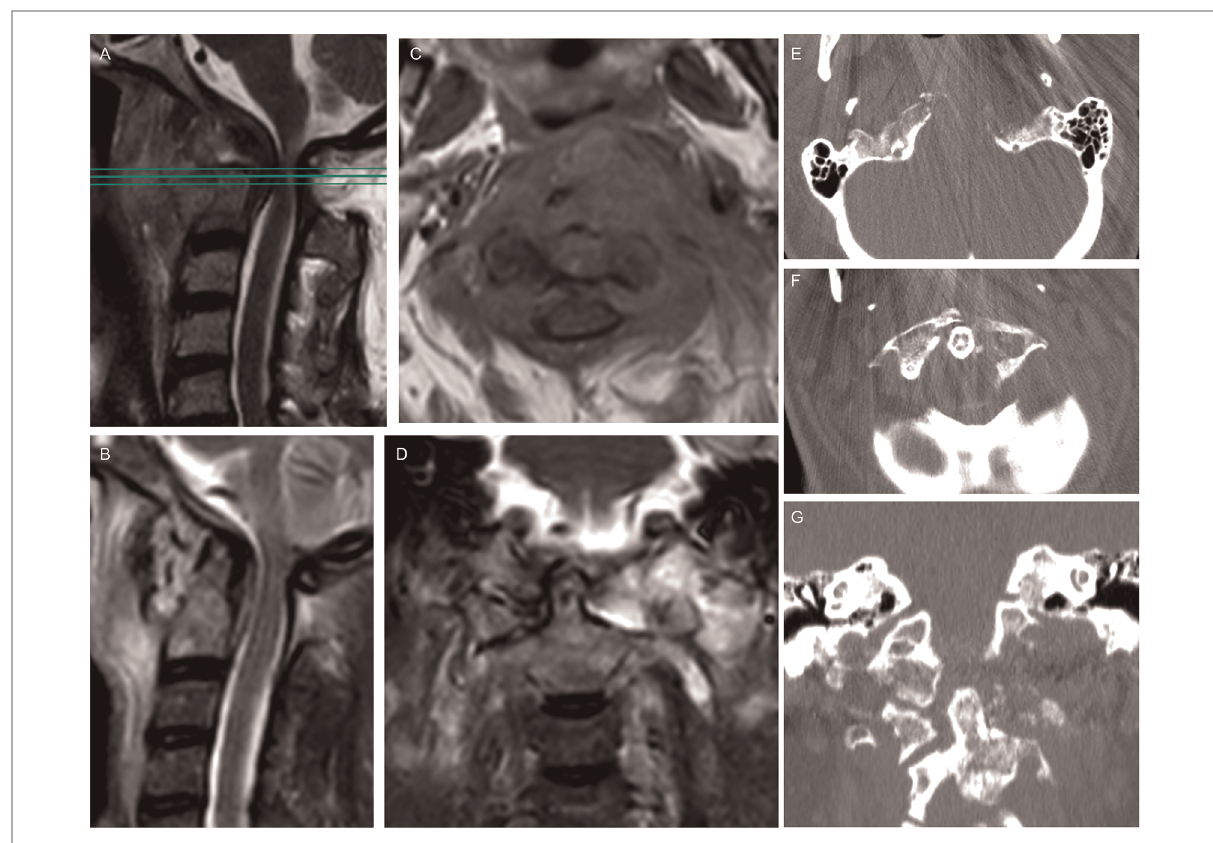
FIGURE 1 Preoperative spine MRI showed a compression of the midbrain at the craniovertebral junction on the STIR sequence ( A ); an axial section contrastenhanced T1-weighted ( C ) depicted a low-enhancing lesion with extension from the clivus, left petroclival fi ssure, and left condyle up to the prevertebral plane of the fi fth cervical vertebral body, determining an anterior dislocation of the oropharynx and an osteolysis of the left part of anterior C1 arch; the lesion showed an hyperintensity in T2-weighted images ( B, D ). Preoperative CT scan showed an osteolytic involvement of the left condyle and lateral mass ( E-G ) causing instability of the craniovertebral